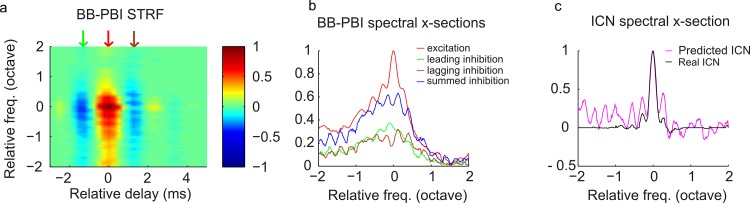
Constructive and destructive interference through integration of broadband PBI explains frequency sharpening of ICNs.(a) Population-average broadband PBI STRF has leading (green arrow) and lagging (brown arrow) inhibition around a central broadband excitatory domain (red arrow). (b) The spectral cross-sections are shown for the excitatory domain (red) along with the leading (green) and lagging (brown) inhibition and the summed inhibition (blue, leading + lagging component). The excitation has a sharp central peak around 0 octave frequency and adjacent peaks at intervals of approximately 0.28 octave. The summed inhibition has a broad profile with peaks that are spectrally displaced (out of phase) with the excitatory peaks. Upon summing the excitation and inhibition, the broad spectral structure cancels, and the narrowly tuned central region is preserved (panel c, magenta), which predicts the sharpened frequency tuning observed for ICNs (panel c, black, population-average ICN spectral cross-section). Underlying data can be found in S7 Data and S7 Code. BB, broadband; ICN, inferior colliculus neuron; PBI, putative brainstem input; STRF, spectrotemporal receptive field.